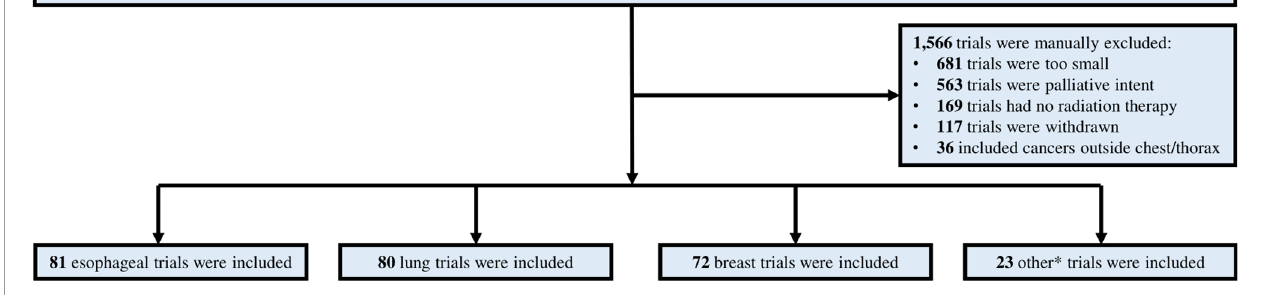
FIGURE 1 | Study schema documenting identi fi cation of trials meeting inclusion criteria. *other = lymphoma, mesothelioma, and